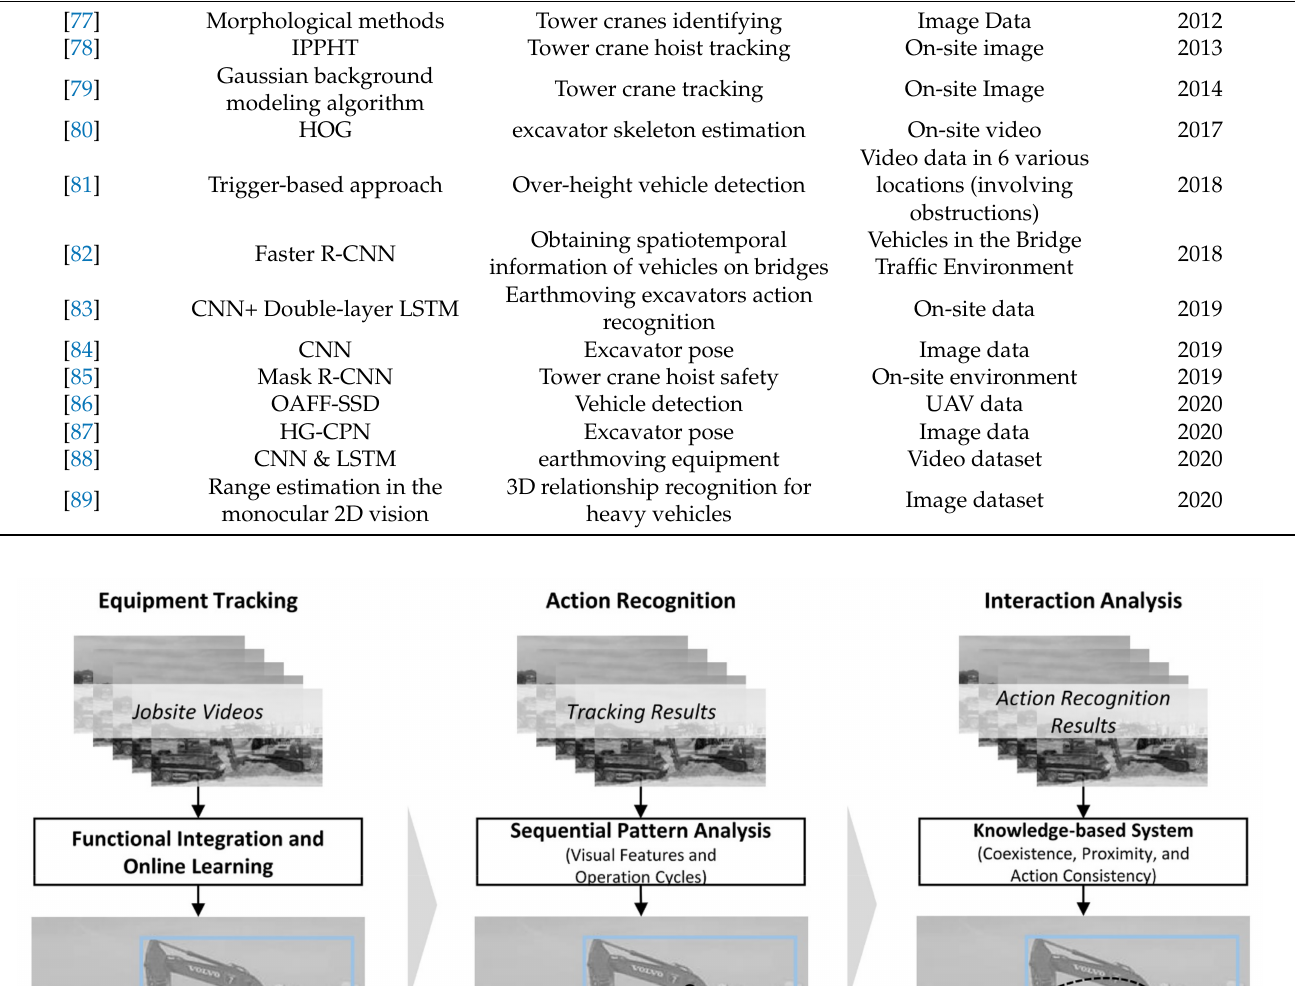
Table 3. CPS on a construction site.